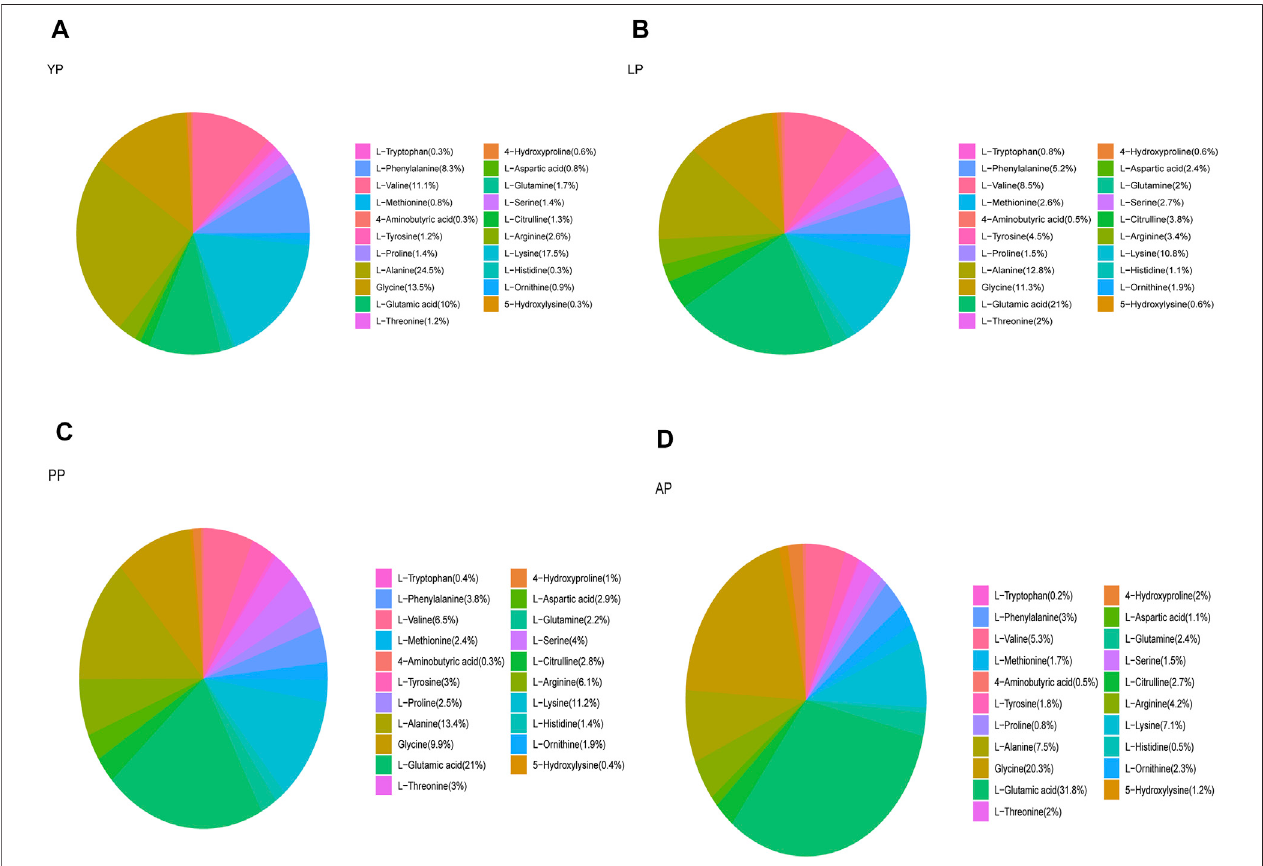
FIGURE 3 | We detected the amino acid content of all fresh pericardium and count the proportion of amino acids in each group of pericardium. (A) , Fresh yak pericardium (YP) amino acids; (B) , Fresh local bovine pericardium (LP) amino acids; (C) , Fresh porcine pericardium (PP) amino acids; (D) , Fresh Australian bovine pericardium (AP) amino